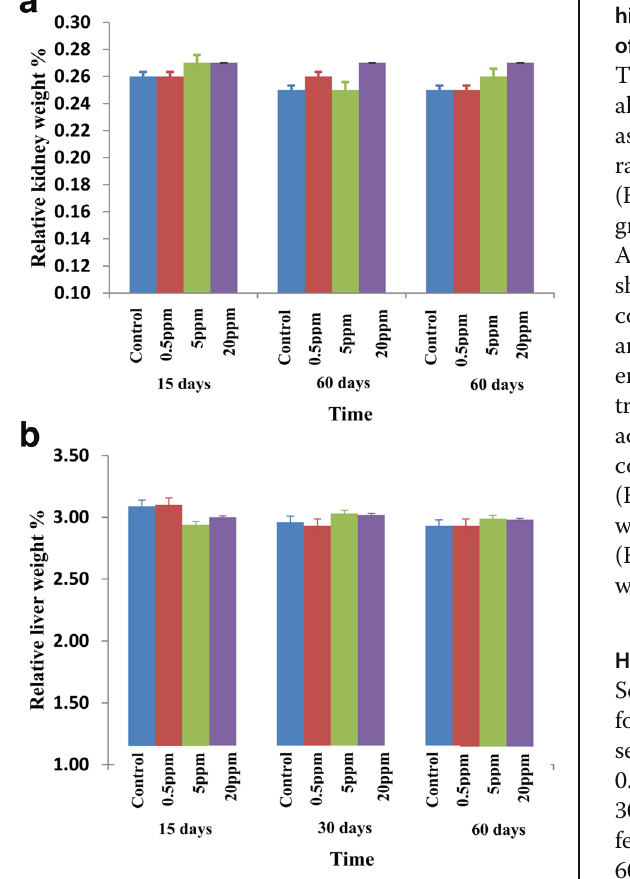
Fig. 1 Relative organ weights of rats treated with fluoride. a Relative kidney weights. b Relative liver weights of rats exposed to distilled water (control) and different concentrations of fluoride (0.5, 5, and 20 ppm) for 15, 30, and 60 days. Error bars represent standard